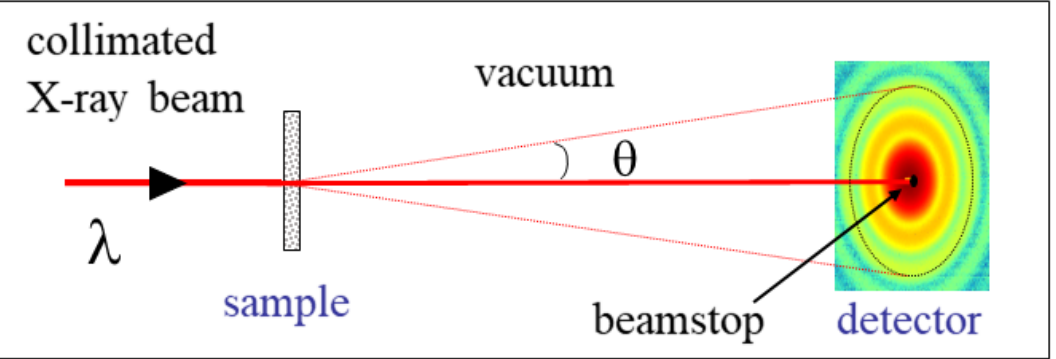
Figure 1. Schematic representation of a SAXS experiment set-up showing the incident, scattered, and transmitted beams; the 2D detector; and the